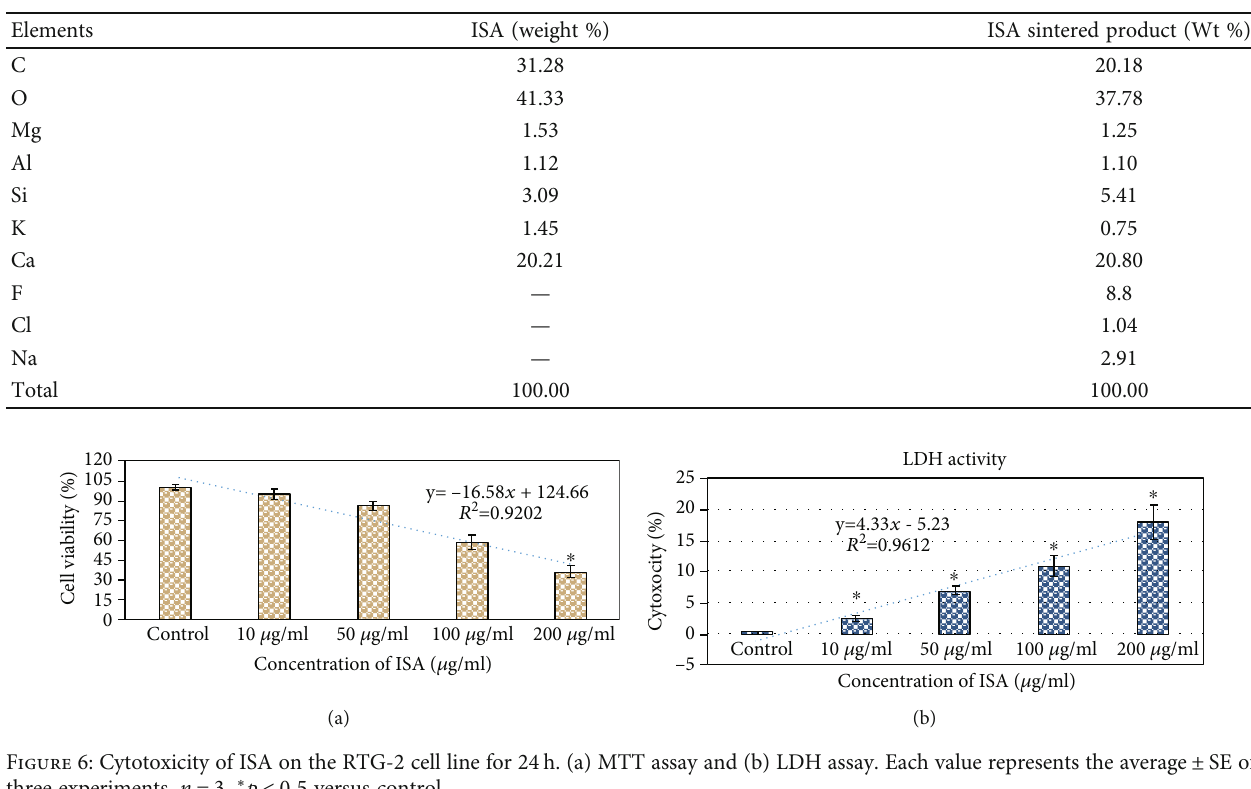
Table 3: Elemental analysis of ISA and ISA sintered product by EDS.